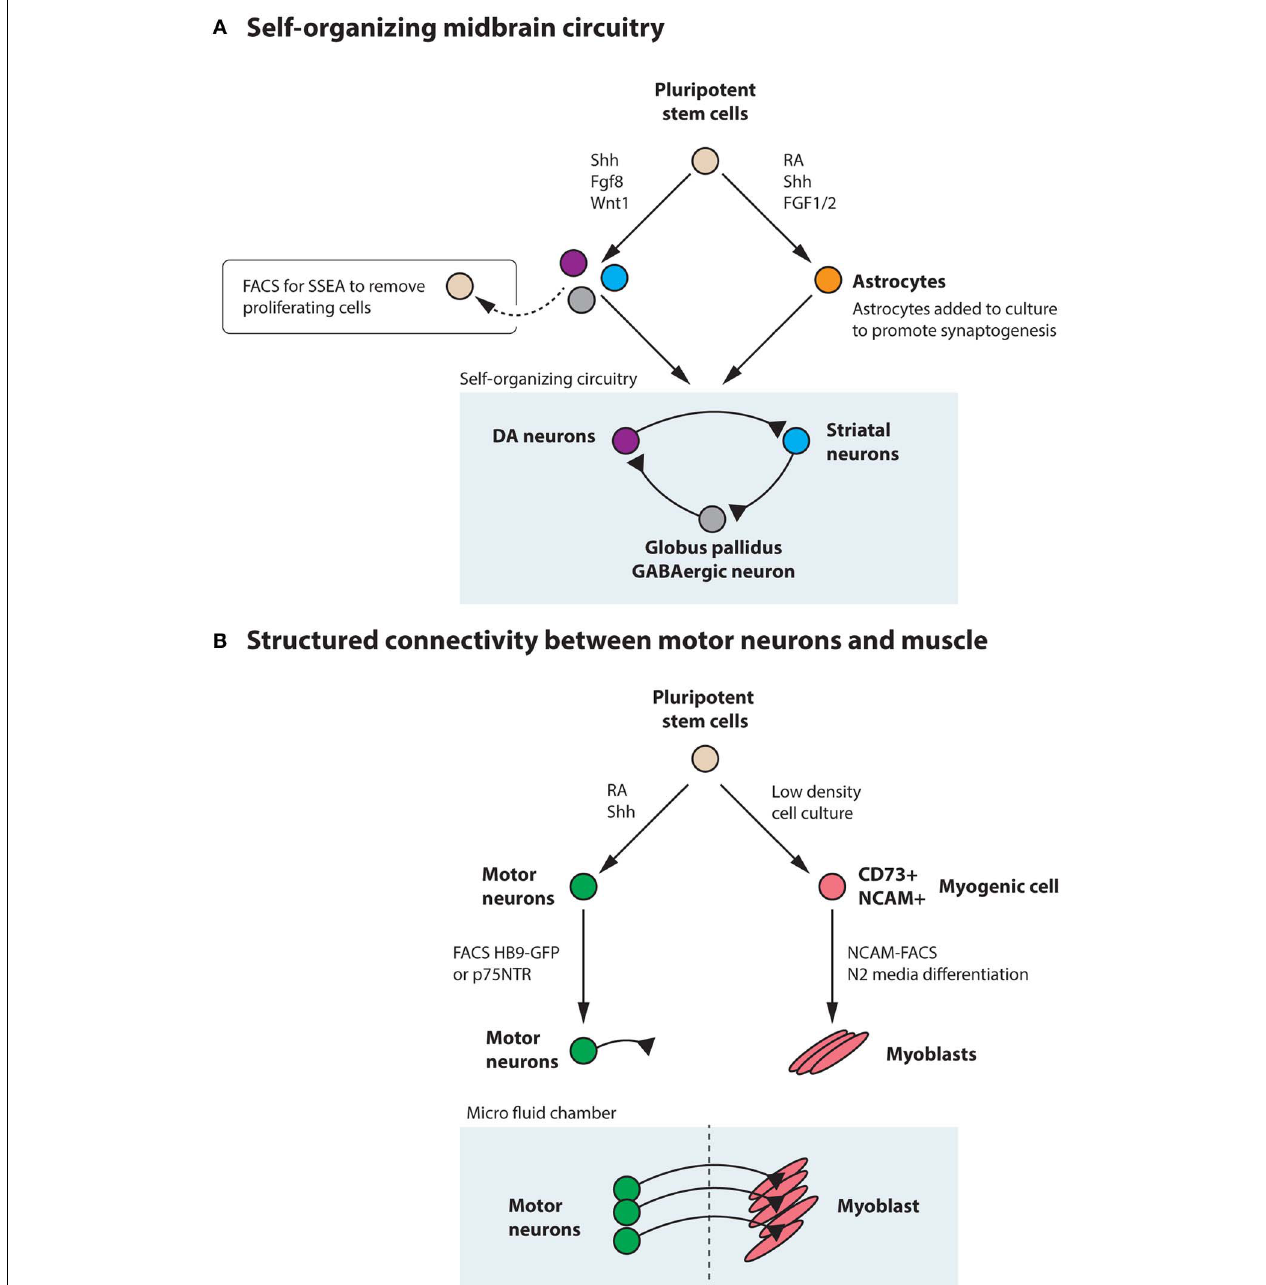
FIGURE 8 | Pluripotent stem cells could be utilized to generate a self-organizing midbrain circuitry or structured connectivity between motor neurons and muscle. (A) Utilizing the morphogens Shh, Fgf8, and Wnt1, pluripotent stem cells generate dopamine neurons, striatal neurons, and GABAergic neurons that could form a self-organizing circuitry during appropriate conditions. Remaining pluripotent stem cells could be removed by FACS for SSEA. Astrocytes, generated from stem cells through the action of RA, Shh, and FGF1/2 could be added to the culture to promote